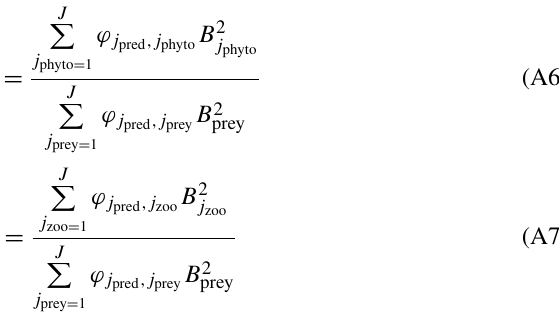
present the results with the prey refuge excluded (Figs. 4–7,